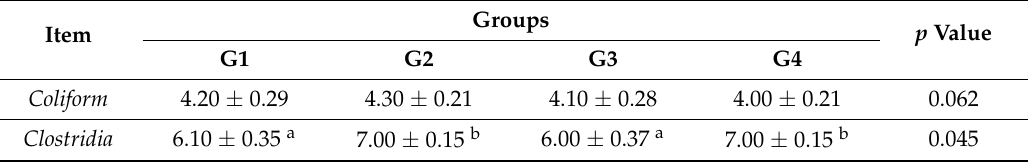
Table 5. Haemagglutination inhibition (HI) titers for Newcastle disease virus (NDV) in the collected serum samples at 21 and 35 days of age in broiler